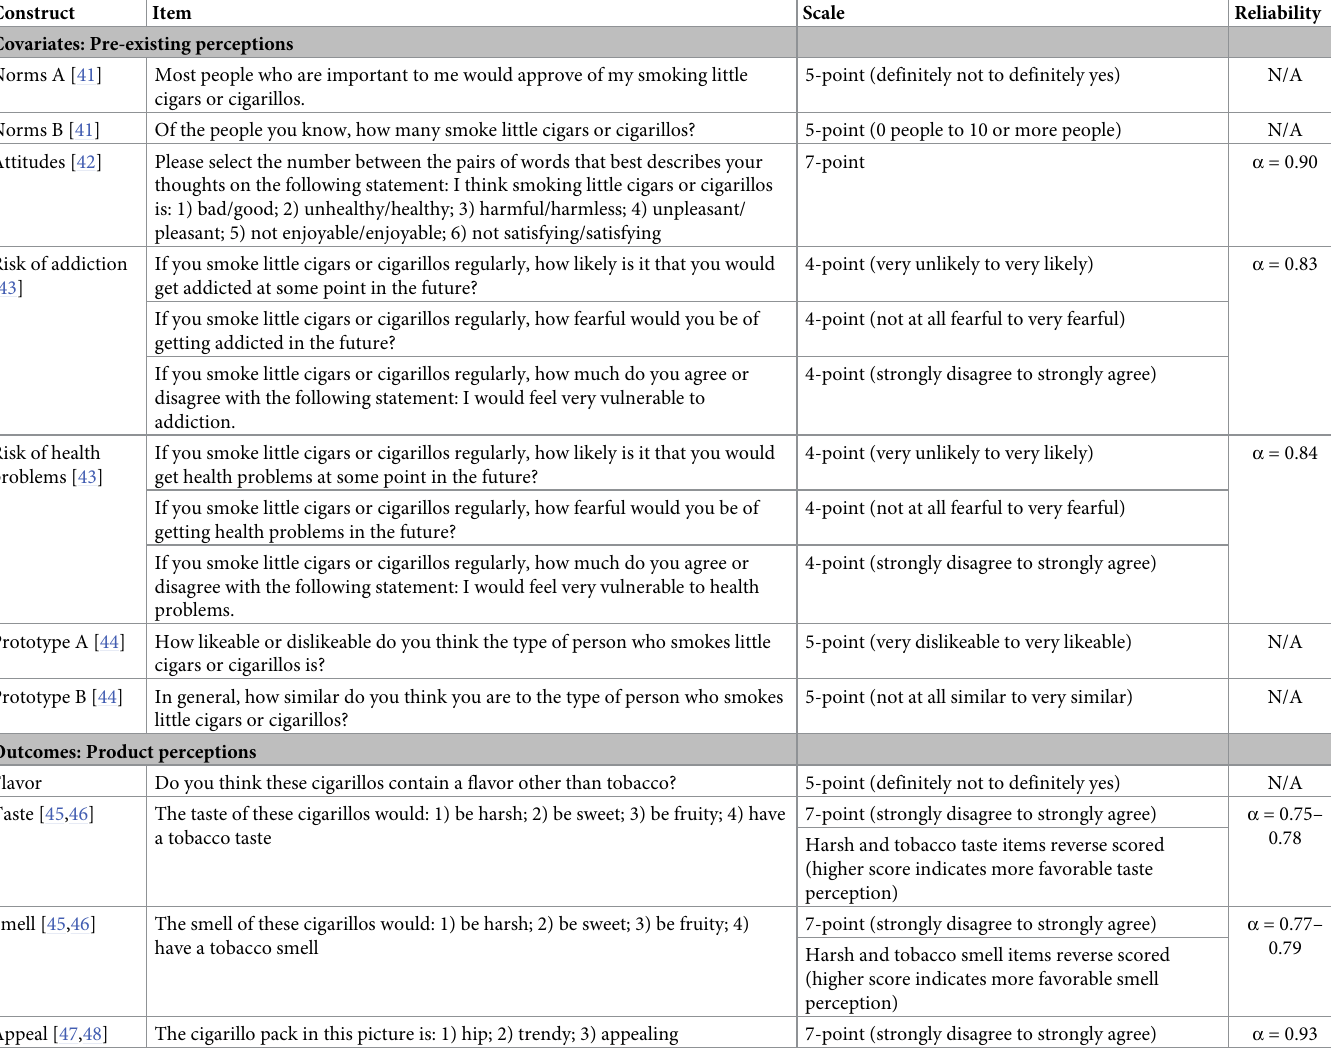
Table 1. Covariates and outcome